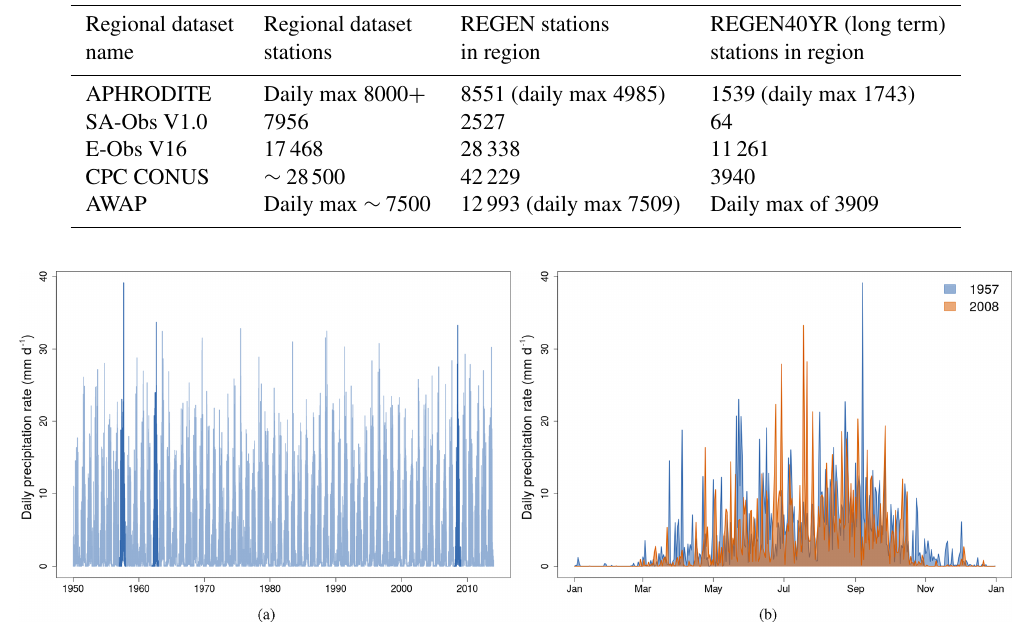
Figure 9. Time series of daily precipitation from REGEN averaged over Benin in western Africa. Panel (a) shows the entire time series from 1950 to 2016 with the years containing the days with the highest three daily rainfall rates (1957, 1963 and 2008) shown in a darker shade. Panel (b) shows a comparison of the time series of daily rainfall between 1957 (year containing the day with the record highest rainfall based on REGEN) and 2008 (year during which the 2008 Benin floods occurred). Benin was chosen because of its good coverage of